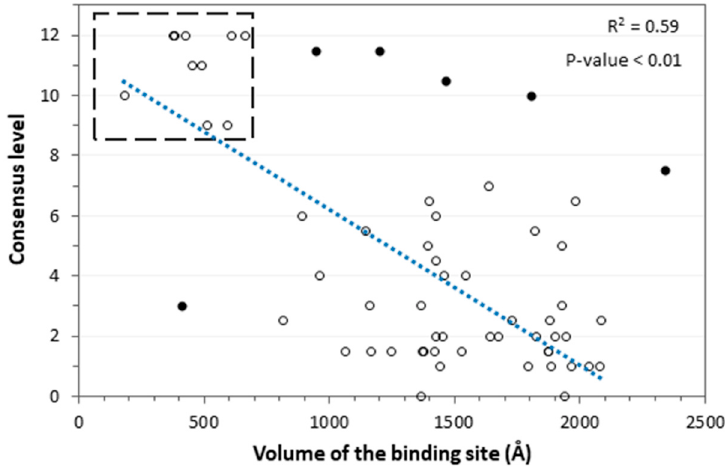
Figure 4. Analysis of the consensus docking results in relation to the target properties. The trend line is displayed as a dashed blue line. Closed black circles represent targets that did not show any link between the volume of the protein binding site and the consensus level.